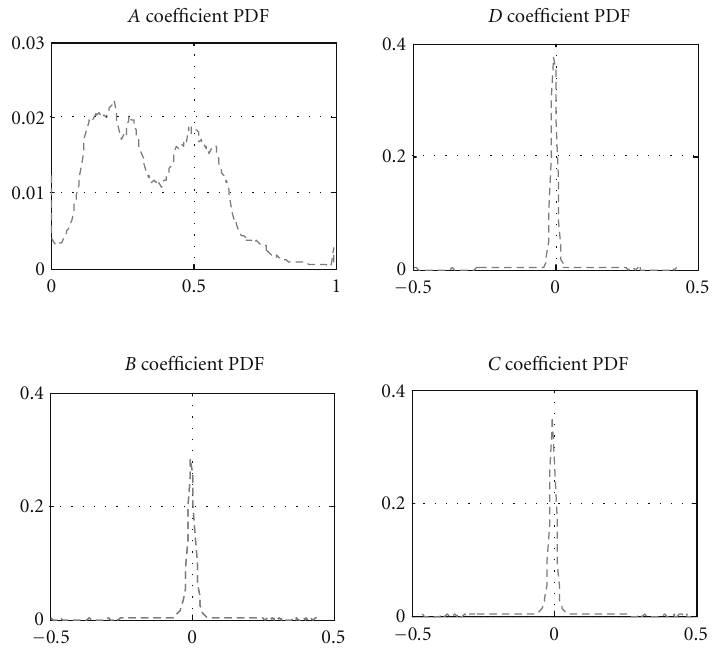
Figure 3: PDFs of the binning and detail coe ffi cients of the raw infrared